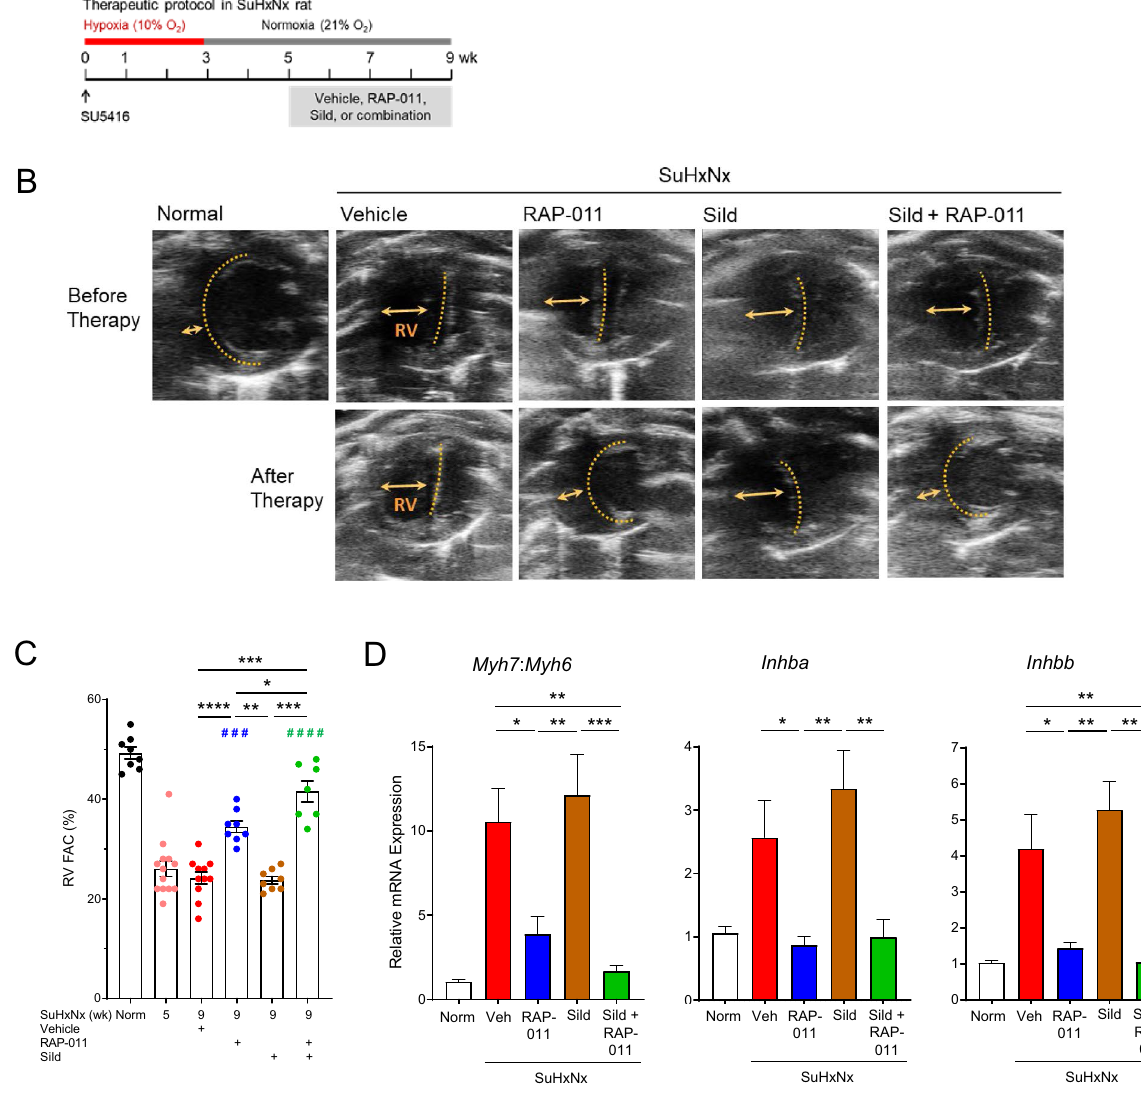
Figure 4. ActRIIA-Fc reverses cardiac remodeling and expression of key cardiac genes in severe experimental PAH. ( A ) Experimental approach used to evaluate therapeutic effects of RAP-011 in the SuHxNx rat model of severe PAH. See Fig. 1 for details. ( B ) Pairs of representative echocardiographic images obtained at the end of diastole from the same SuHxNx rats before and after therapy. ( C ) RV fractional area change (RV FAC). Data are means ± SEM (n = 7–11 rats per group). ( D ) Ratio of myosin heavy-chain isoform expression ( Myh7 : Myh6 ) and levels of Inhba and Inhbb in the RV of normal or SuHxNx rats. Data are means ± SEM (n = 6–11 rats per group). Analysis by one-way ANOVA and Tukey post hoc test (*P < 0.05, **P < 0.01, ***P < 0.001, ****P < 0.0001; ### P < 0.001 vs. wk 5, #### P < 0.0001 vs. wk